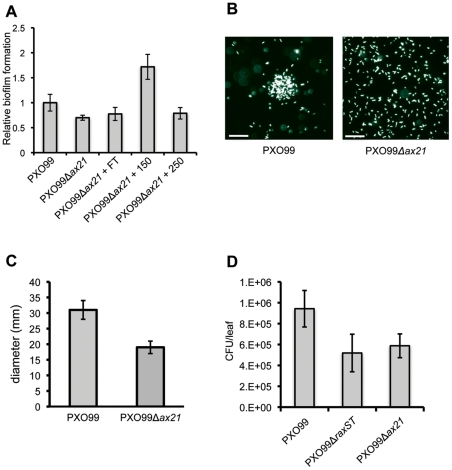
Ax21 regulates Xoo biofilm formation, cell aggregation, motility, and virulence.(A) Biofilm formation of PXO99, PXO99Δax21, PXO99Δax21 supplemented with exogenous addition of the flow-through (FT), 150 mM (150), or 250 mM (250) imidazole buffer-eluted fractions (figure S2) were measured according to absorbance at A590 using the polyvinyl chloride plate assay and normalized with the value of PXO99. Bars represent the mean of ten biological replicates ± SD. (B) Aggregation assays were performed using PXO99 and PXO99Δax21 strains carrying a green fluorescent protein. Xoo strains were observed with a microscope equipped with a fluorescein isothiocyanate filter (excitation filter, 450 to 490 nm; emission filter, 520 nm; dichroic mirror, 510 nm). The bars indicate 10 µm. (C) Swimming motility of PXO99 and PXO99Δax21 strains were quantified by measuring the diameter of colony expansion in swimming motility assays. Bars represent the mean of four biological replicates ± SD. (D) Virulence of PXO99 and PXO99Δax21 was monitored at low population densities. Rice leaves (TP309 cultivar) were inoculated with PXO99, PXO99ΔraxST, and PXO99Δax21 strains using the soaking method (103 CFU/ml) for two days. Bacterial populations were determined two days after inoculation. Bars represent the mean from at least seven leaves ± SD. The experiment was repeated four times with similar results.